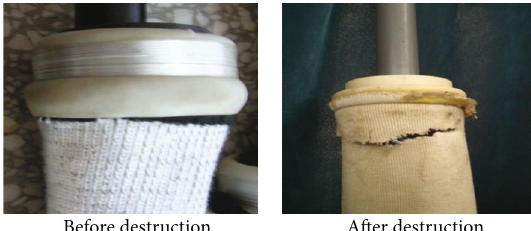
Figure 8: Destruction form of capsule.